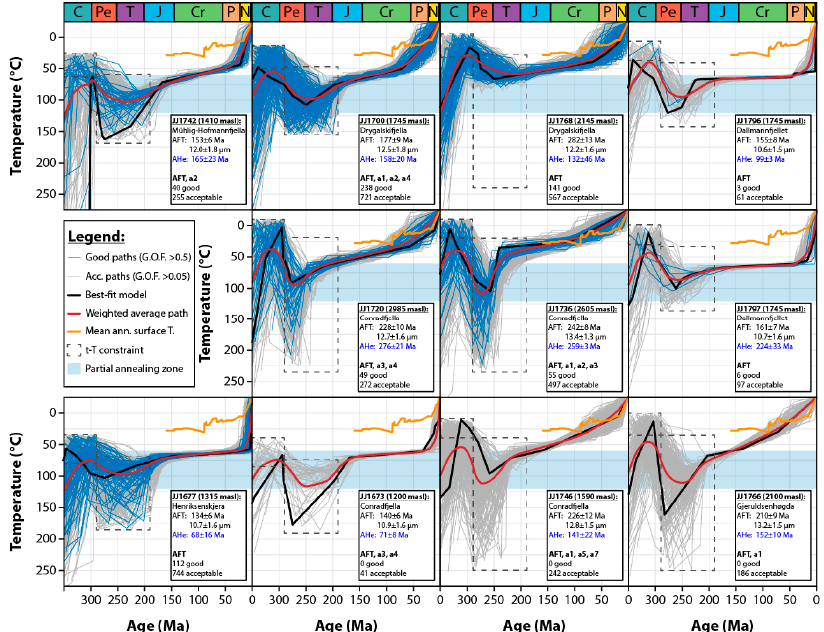
Figure 6. Time–temperature paths generated by the HeFTy software [89] for Orvinfjella and Mühlig-Hofmannfjella. 100,000 random paths were tested for each sample. For each sample, AFT central age and mean track length (black) are reported with 1 σ error. AHe age (blue) is given as unweighted mean age with 1 σ error. Below that: (1) In bold, the thermochronometers included in the specific thermal model; the “a” numbers indicate the considered AHe single-grain analyses. (2) The number of good and acceptable paths found for each model. Good fits represent goodness-of-fit ≥ 0.5, while acceptable fits correspond to goodness-of-fit ≥ 0.05. Mean annual surface temperatures after Barrett [107], Poole et al. [108], Thorn and DeConto [109] and Jenkyns et al. [110].